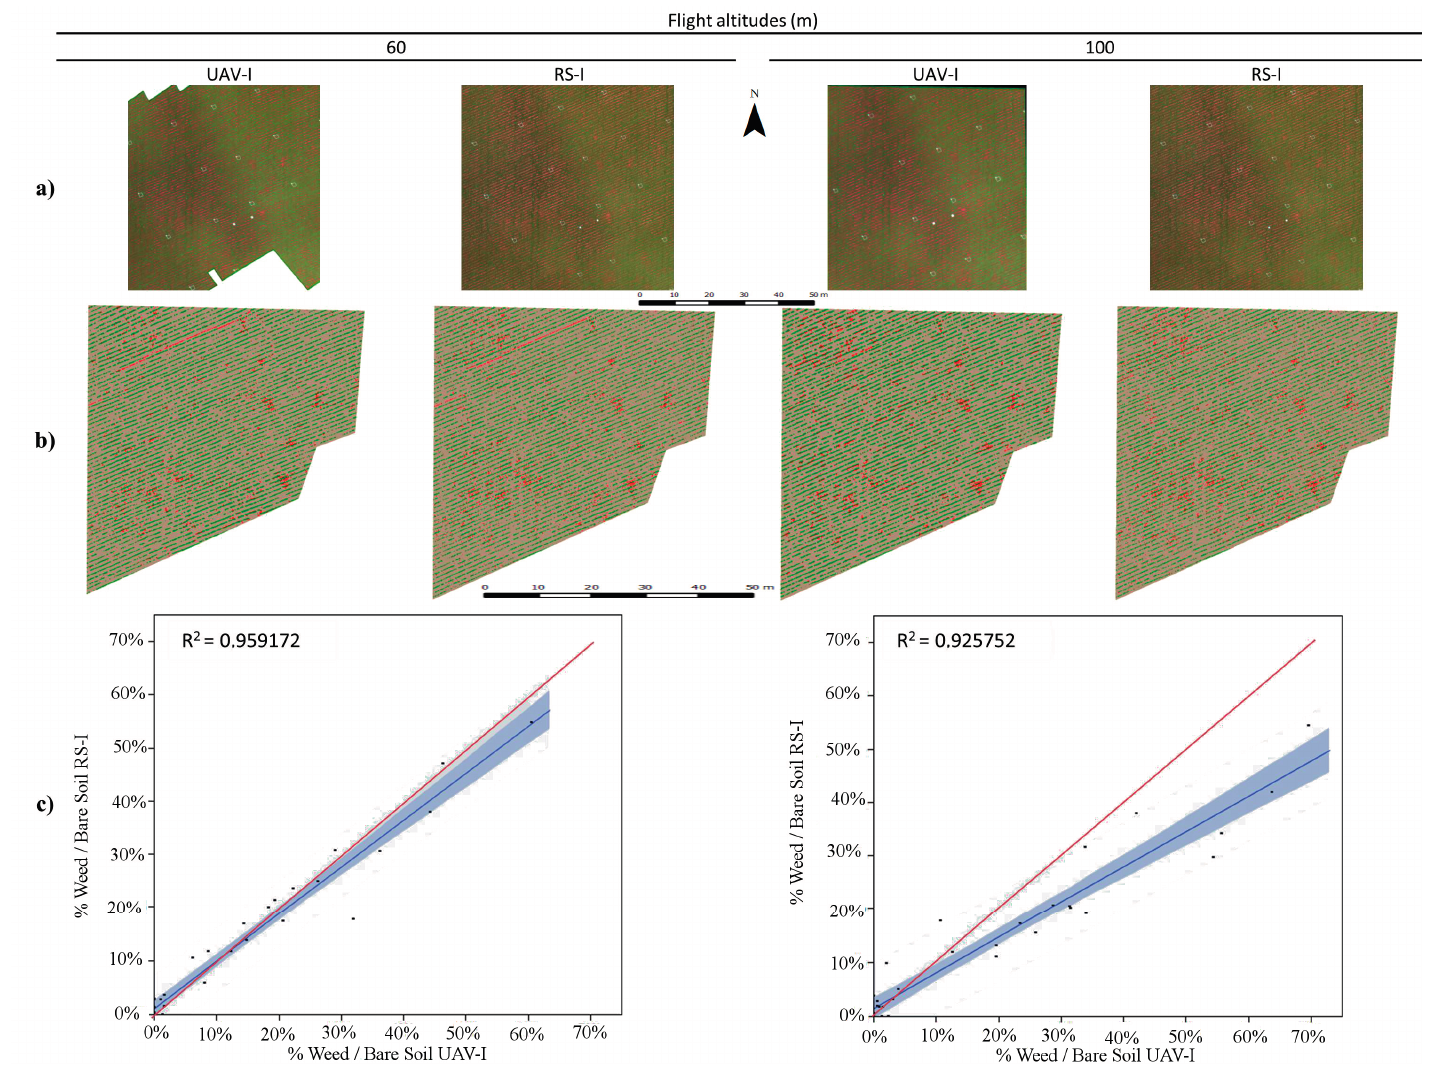
Figure 4. ( a ) Portions of UAV-image taken with the multispectral camera and RS-image; ( b ) maps obtained using OBIA; and ( c ) graphics comparing UAV-image and RS-image estimated weed cover in the 32 frames established in Field